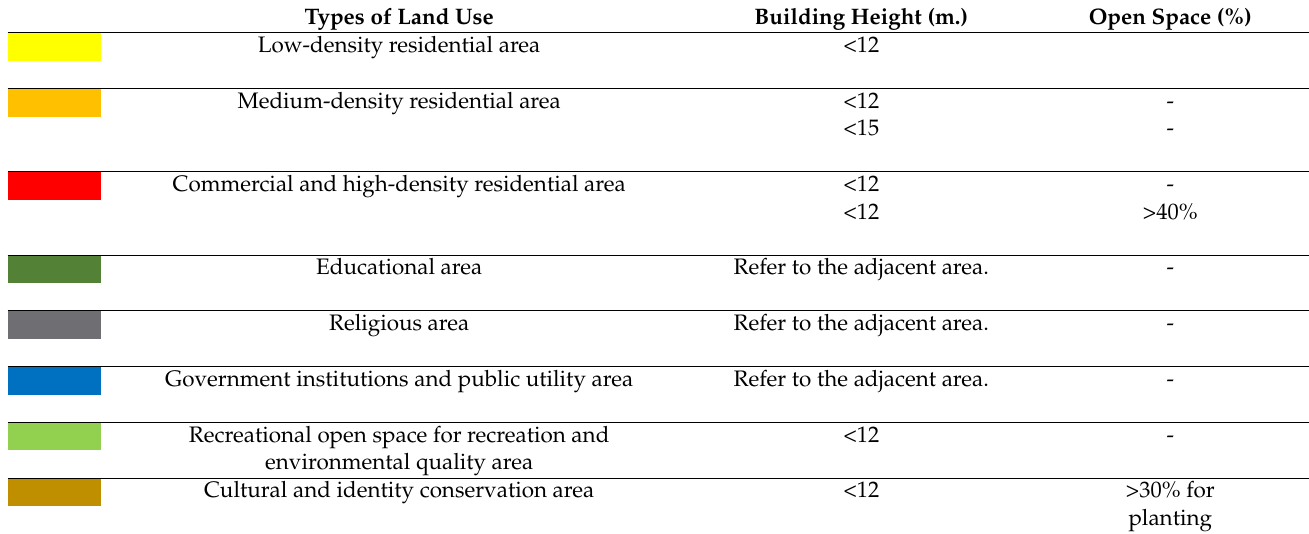
Table 1. Building Heights Allowed According to Chiang Mai City Comprehensive Plan